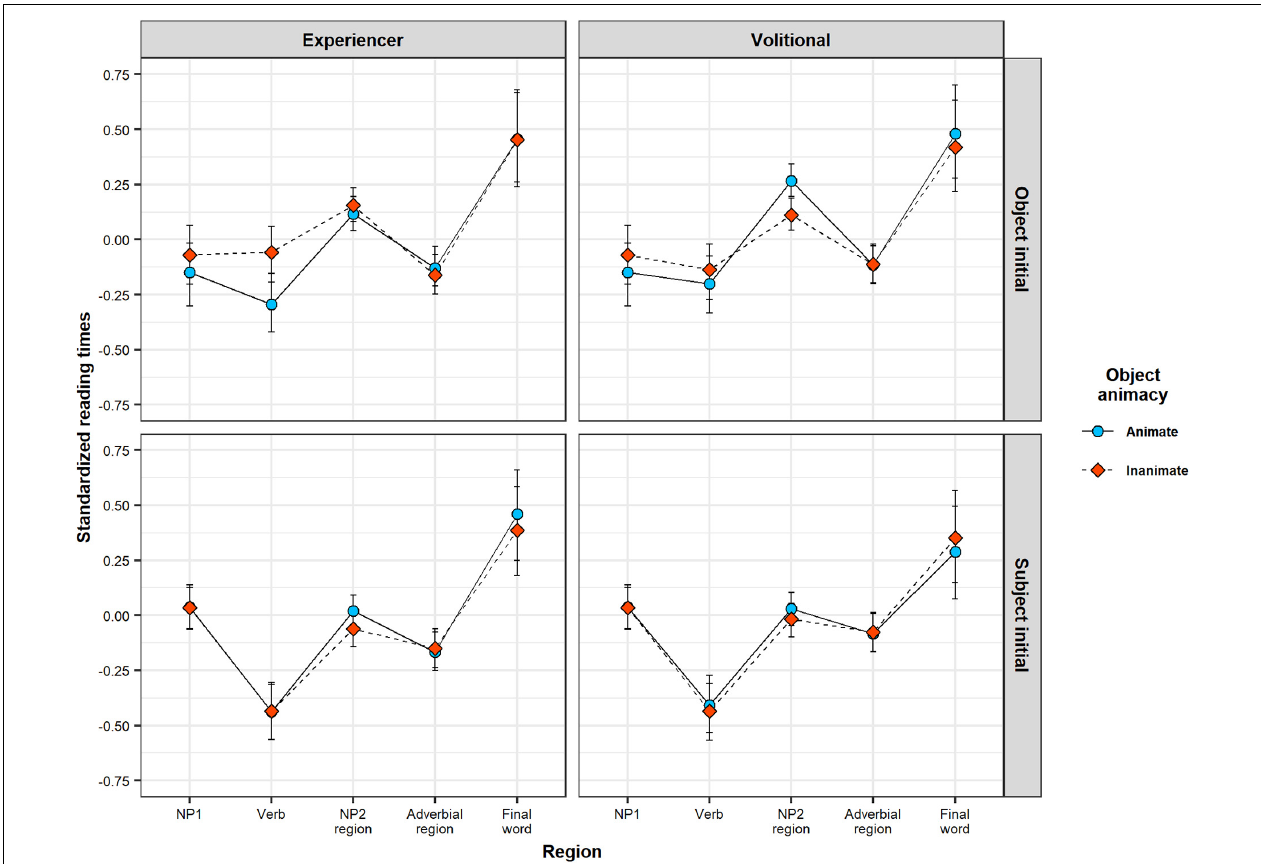
FIGURE 6 | Bayesian LMM model MAP estimates of standardized RTs in each sentence region as function of animacy, separated by verb class (experiencer vs. volitional) and constituent order (OVS vs. SVO). Error bars illustrate 89%